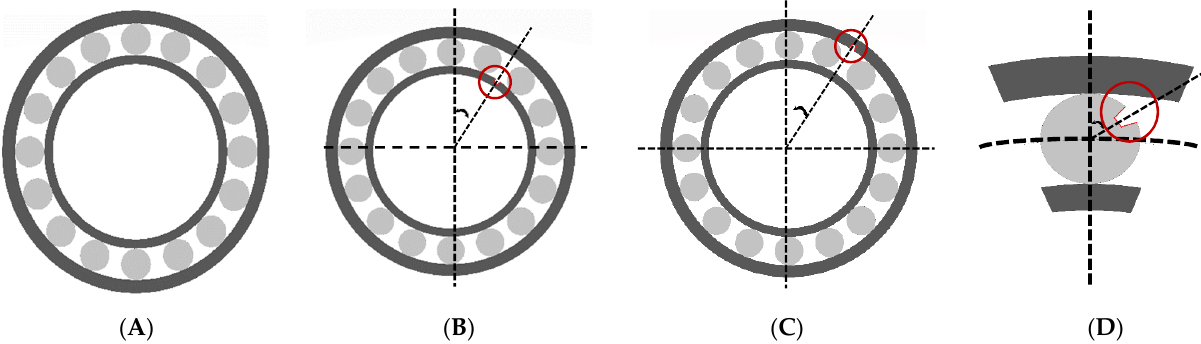
Figure 2. Bearing conditions: ( A ) normal; ( B ) inner race failure; ( C ) outer race failure; ( D ) ball failure.